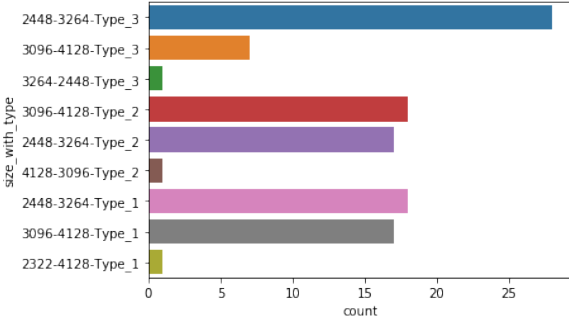
Figure 4. Size vs. Frequency of